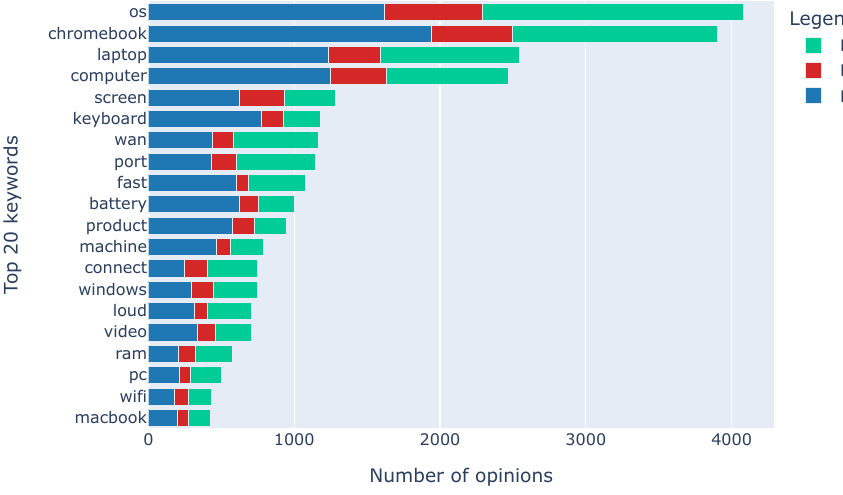
Figure 6. Distribution of opinion interest intensity on top 20 aspect